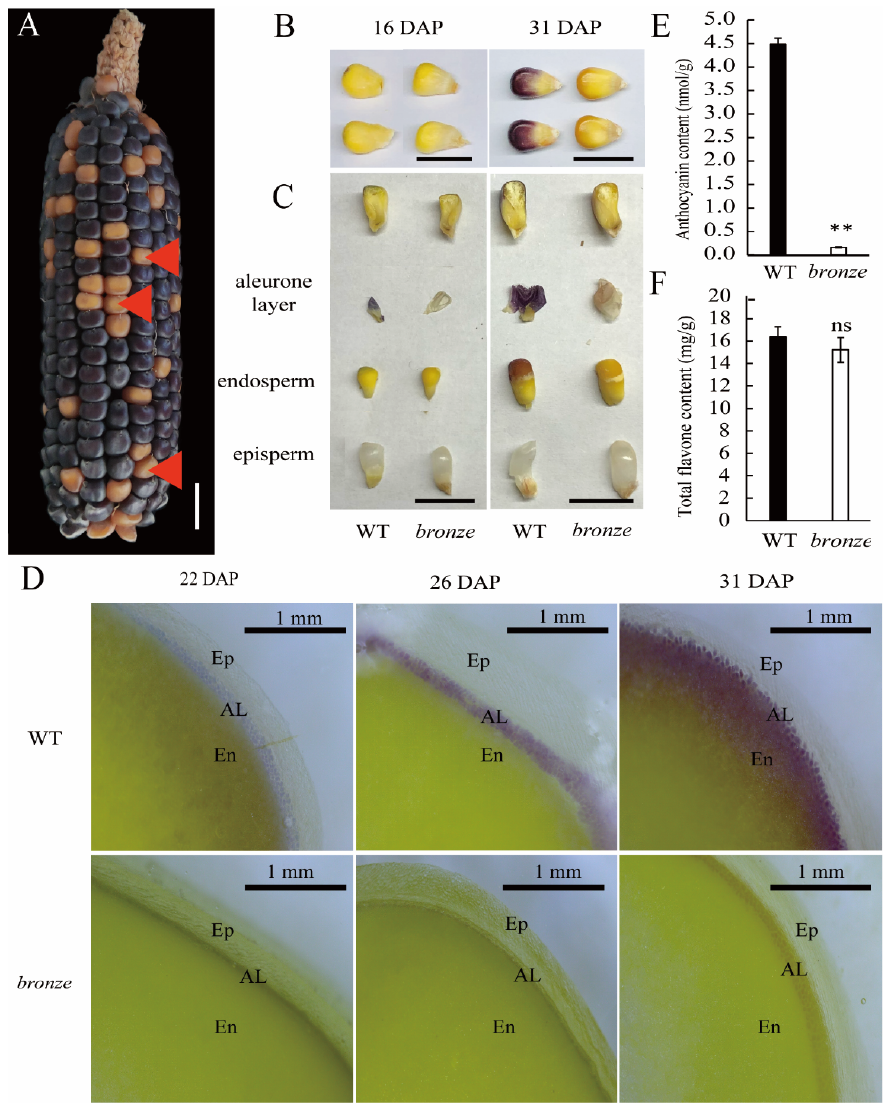
Figure 1. Phenotypic analysis of WT and bronze mutant. ( A ) Mature ear of F 2 from selfed F 1 ( bronze /+) plant. The mutants (bronze colored seed) were labeled as red solid triangles. Bar = 1 cm; ( B ) Developing seeds of WT (purple colored) and mutants at 16 and 31 DAP. Bar = 1 cm; ( C ) Separated parts of above developing seeds by longitudinal sections, including whole seeds, separated aleurone layer, endosperm and the seed coat (pericarp) for WT and mutant at the stage of 16 and 31 DAP. Bar = 1 cm; ( D ) Slicing of developing seeds at 22, 26 and 31 DAP photographing on a stereomicroscope. Ep, Episperm; Al, aleurone layer; En, endosperm. Bar = 1 mm; ( E , F ) Anthocyanins content ( E ) and total flavonoids content ( F ) of WT and mutant seeds. The asterisk indicates a significant difference relative to WT (Student t -test: ** p < 0.01; ns means no significant difference).